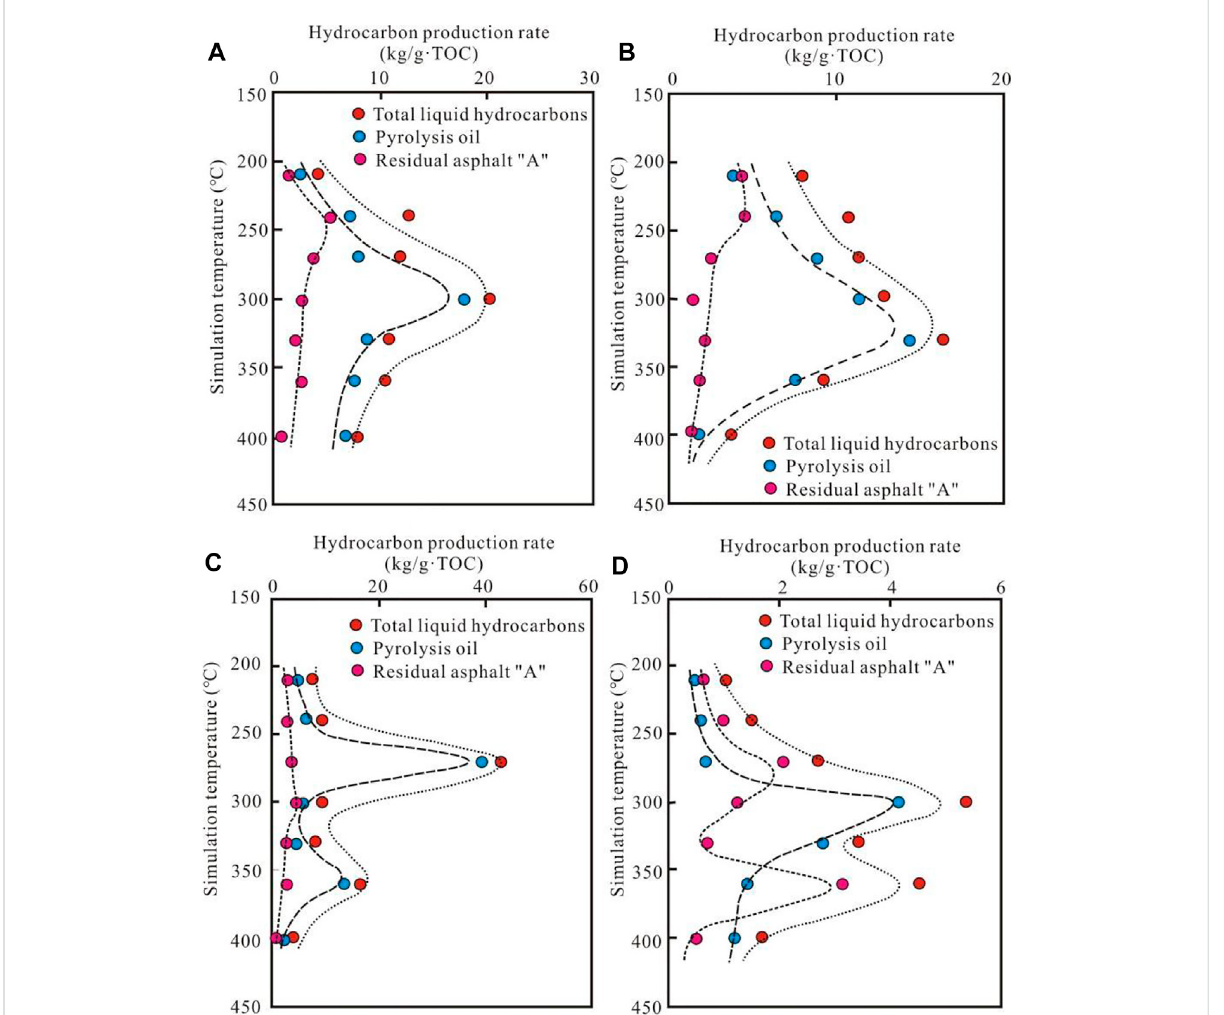
FIGURE 8 Yields of liquid hydrocarbons in thermal pressure simulations of coal rocks, carbonaceous mudstones, and coal-measure mudstones in the Middle and Lower Jurassic in thestudy area. Notes: (A) Well Ma 1,dark graymudstone; (B) Well Yannan 1,dark gray mudstone; (C) Hua ’ an Coal Mine, coal; (D) Well Yan 2, carbonaceous